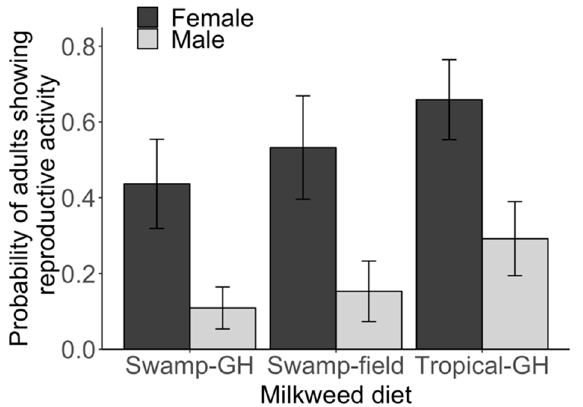
Figure 2. Reproductive activity in monarchs based on milkweed diet and sex. The probability that males and females show evidence for reproductive activity (mating in males, mature egg presence in females) as predicted by logistic regression model. Milkweed diets included “Swamp-GH”, which is greenhouse-grown native swamp milkweed ( A. incarnata ); “Swamp-field”, or field-collected swamp milkweed ( A. incarnata ) harvested in late summer; and “Tropical-GH,” greenhouse-grown, non-native tropical milkweed ( A. curassavica ). Monarchs fed tropical milkweed ( A. curassavica ) as caterpillars were more likely to show reproductive activity than those fed on native A. incarnata (either greenhouse-raised or field-collected). Females we more likely to show reproductive activity than males. Error bars represent ± SE. Full model output is reported in Table S3.